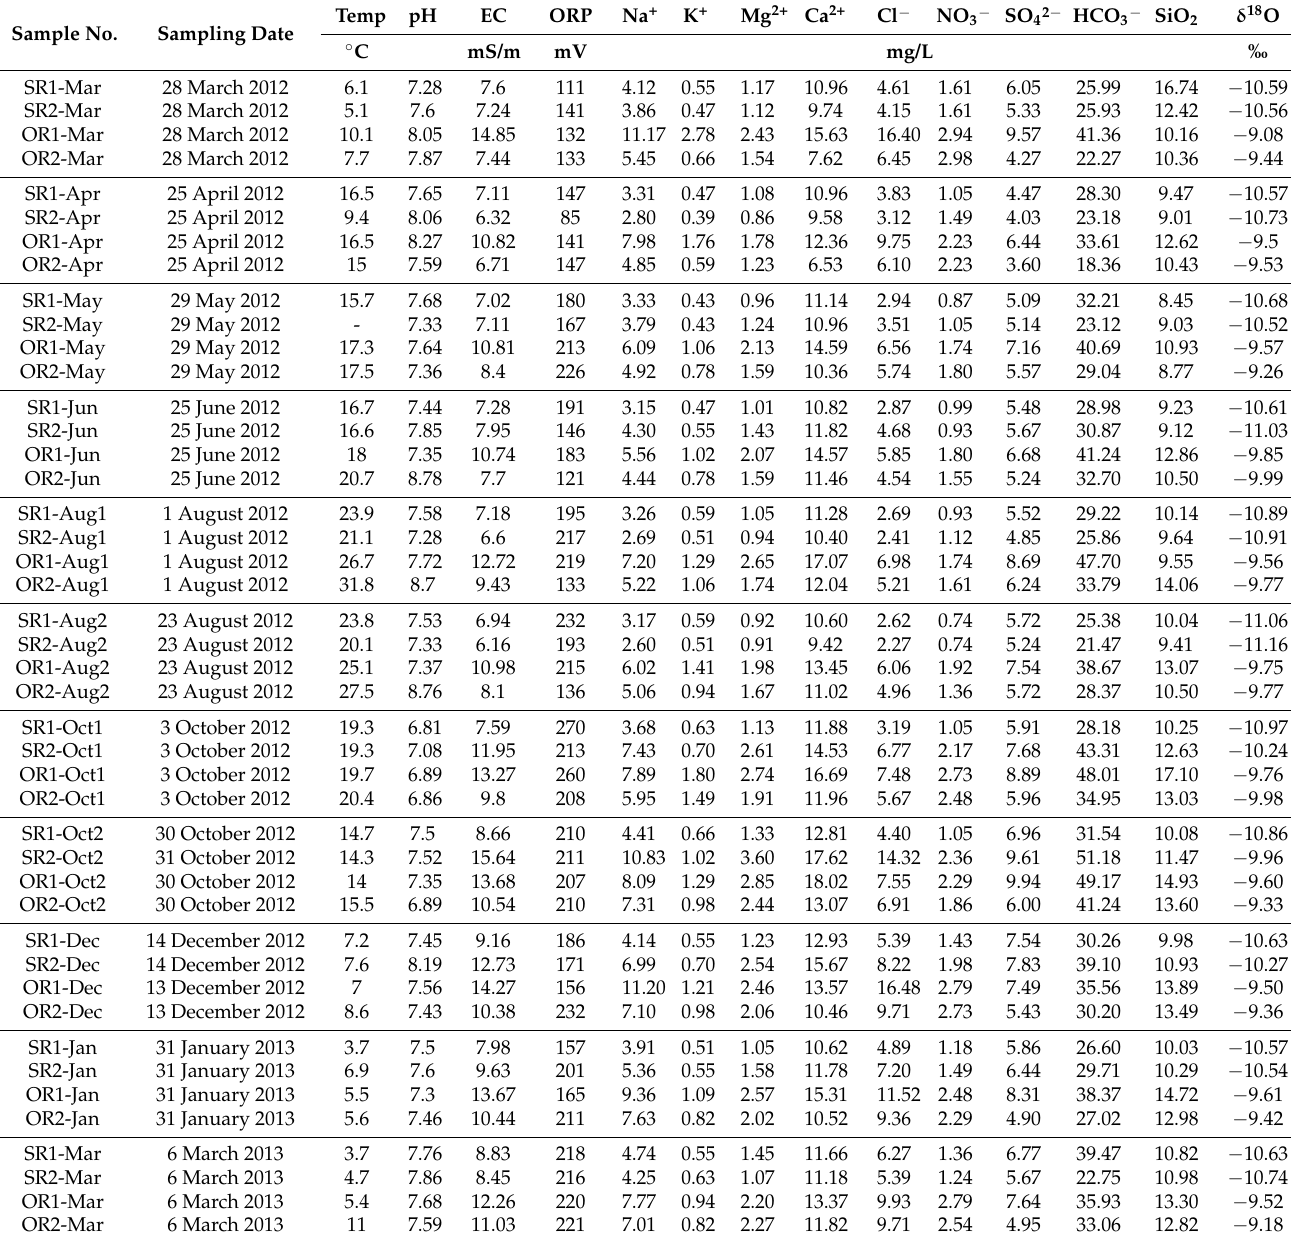
Table 13. Water temperature, pH, EC, oxidation–reduction potential (ORP), and δ 18 O composition for river water samples in the Sho River alluvial fan. Sample